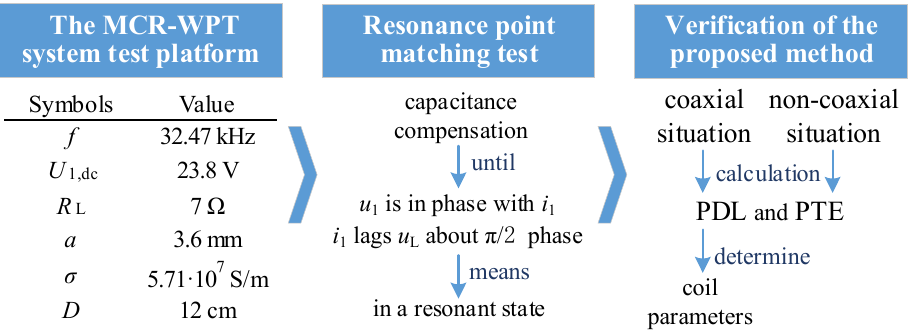
( b ) Figure 6. The PTE and PDL of coil models with the constrained coil parameters: ( a ) PDL; ( b ) PTE. 4. Model Validation and Result Analysis 4.1. Experimental Method The main purpose of this section is to verify the credibility of the proposed method and the